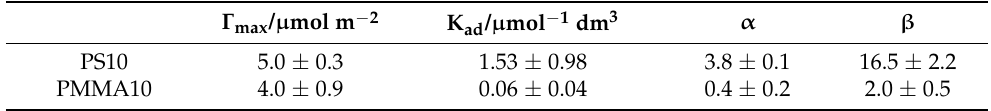
Table 1. Langmuir (maximal surface concentration Γ max , adsorption constant K ad ) and Freundlich ( α , β ) adsorption isotherm parameters for microplastic-adsorbed